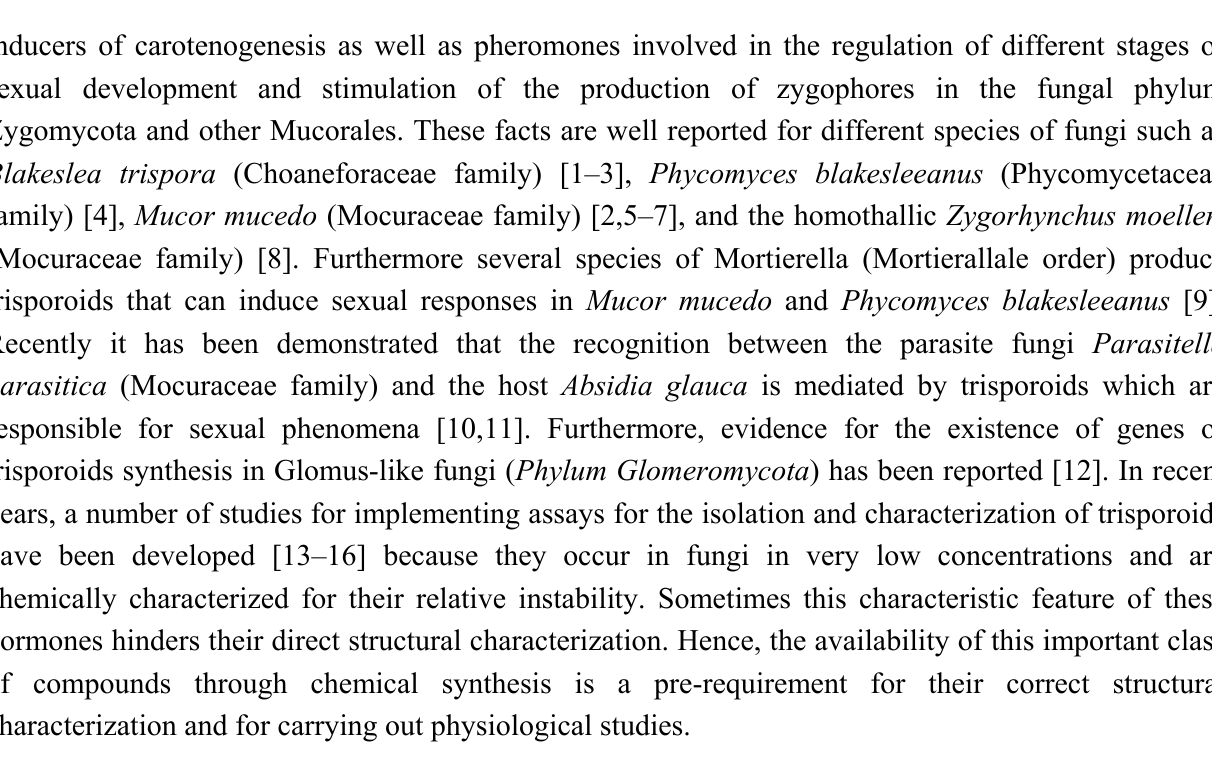
Figure 1. Structural diversity in the family of